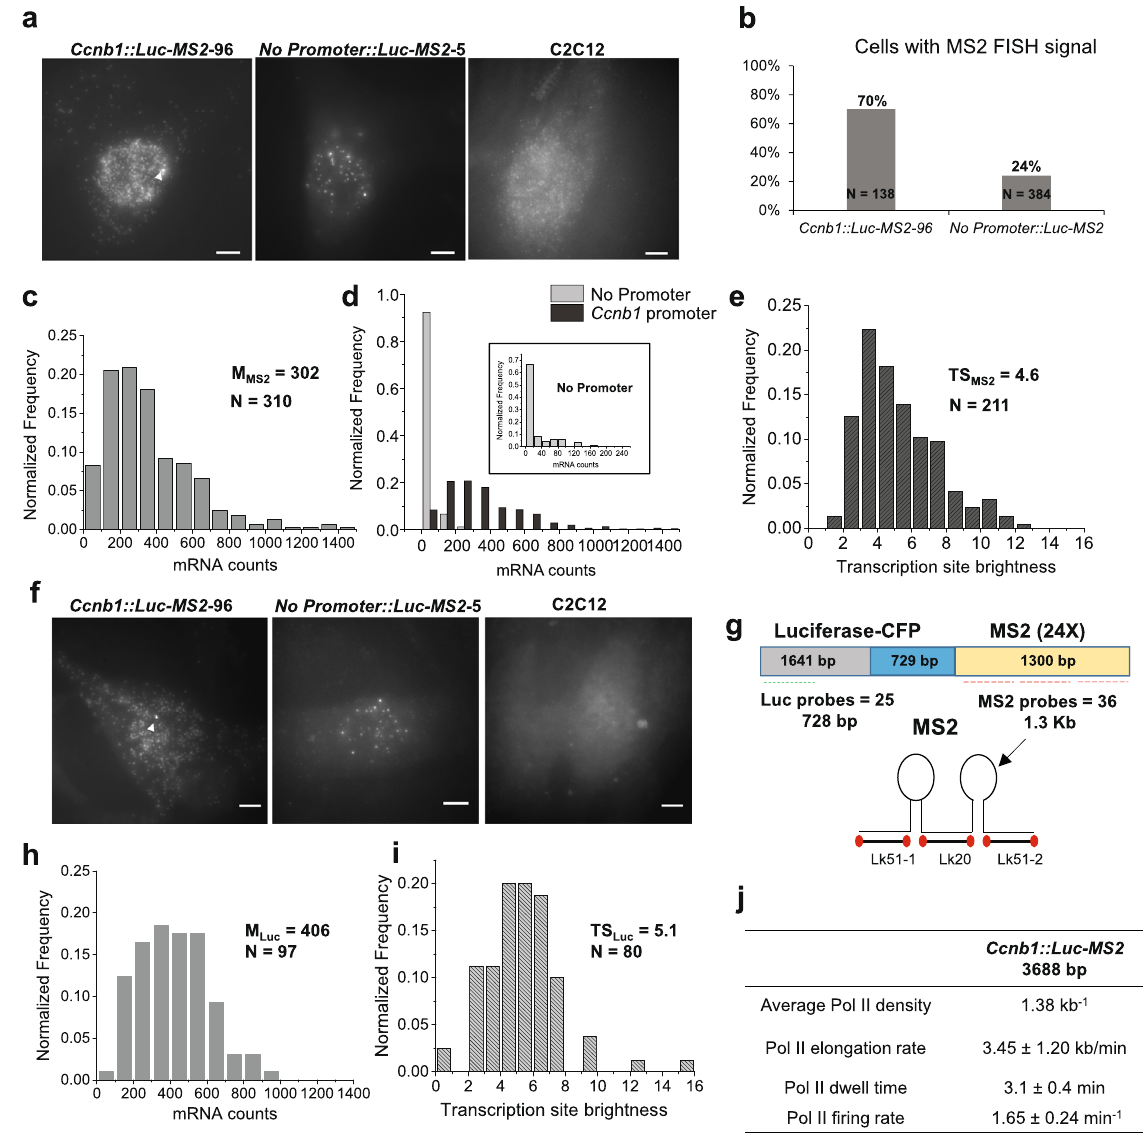
Figure 2. Quantifying mRNA counts and TS brightness from cell clones containing Ccnb1 :: Luc - MS2 and No Promoter :: Luc - MS2 transgenes. ( a ) Representative single molecule RNA FISH images of Ccnb1 :: Luc - MS2 (clone 96), No Promoter :: Luc - MS2 (clone 5) and C2C12 cells using MS2 FISH probes. ( b ) Fractions of cells expressing the Ccnb1 :: Luc - MS2 transgene or No Promoter :: Luc - MS2 transgene (average of three cell clones). ( c ) Histograms of mRNA counts of the Ccnb1 :: Luc - MS2 transgene measured by FISH analysis using MS2 probes. M MS2 indicates the median mRNA count measured by MS2 FISH. N indicates the measured cell number. ( d ) Histograms of transgene mRNA counts in Ccnb1 :: Luc - MS2 clone 96 (dark grey) and No Promoter :: Luc - MS2 cell clones (light grey, average of three cell clones). (Inset) Histograms of mRNA counts in No Promoter :: Luc - MS2 cell clones with a bin of 20. The fraction of No Promoter :: Luc - MS2 cells with zero mRNA counts was included in the histogram plot. ( e ) Histograms of TS brightness of the Ccnb1 :: Luc - MS2 transgene measured by FISH using MS2 probes. TS MS2 indicates the median TS brightness measured by MS2 FISH. N indicates the measured TS number. In panels (c–e), FISH images from three experiments were analysed. ( f ) Representative single molecule RNA FISH images of Ccnb1 :: Luc - MS2 (clone 96), No Promoter :: Luc - MS2 (clone 5) and C2C12 cells using FISH probes targeting the 5 ′ - Luciferase coding region. ( g ) Schematic diagram depicting the Ccnb1 :: Luc - MS2 transgene and positions of FISH probes (not to scale). A mix of twenty-five 5 ′ -labelled probes were used to detect the 5 ′ -portion of the Luciferase coding region of Luc - MS2 mRNA. ( h , i ) Histograms of mRNA counts and TS brightness (indicating nascent transcript counts) of the Ccnb1 :: Luc - MS2 transgene measured by FISH analysis using Luciferase probes. M Luc and TS Luc indicate the median mRNA count and the median TS brightness measured by Luciferase FISH, respectively. N indicates measured cell number and TS number, respectively. FISH images from one experiment were analysed. ( j ) Table summarizing estimated average RNA Pol II density, Pol II elongation rate, dwell time and firing rate at the Ccnb1 :: Luc - MS2 transgene. In panels a and f, white arrowheads indicate the TSs. All scale bars: 5 µ